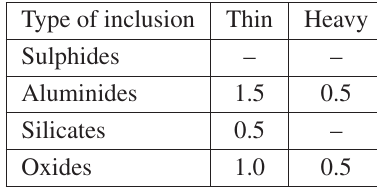
Table 2. Inclusion rating of the